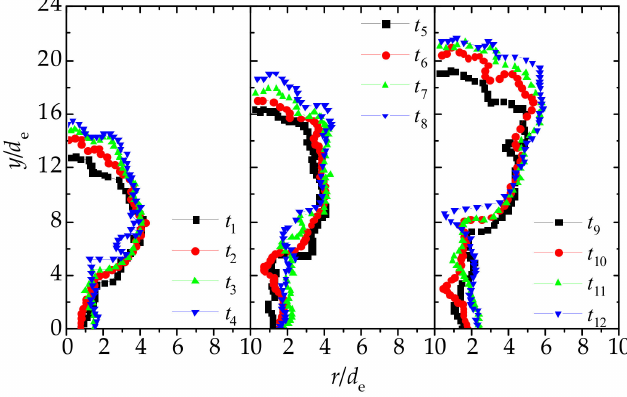
Figure 6. Interfacial diameters of jet boundary (100 m, expansion ratio of